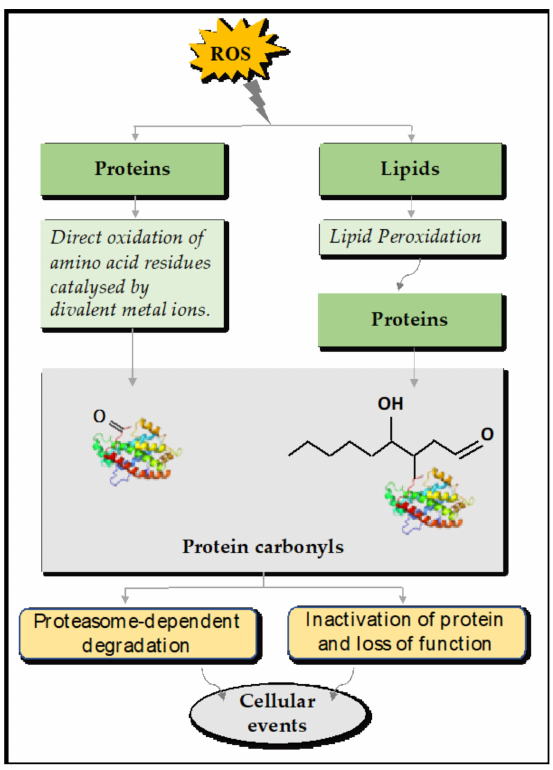
Figure 3. The reactions of protein carbonylation and the fates of carbonylated proteins. Metal- catalyzed oxidation of the side chains of Arg, Thr, Pro, and Lys and addition of lipid peroxidation- derived RCS to the side chains of Cys, His, and Lys represent the two types of protein carbonylation in plants and result in carbonylated proteins. The fates of carbonylated proteins. The carbonylated proteins may lose their activity, change their initial conformation, or aggregate. They are subsequently degraded by the 20S proteasome system. The biological relevance of these changes is further discussed in the